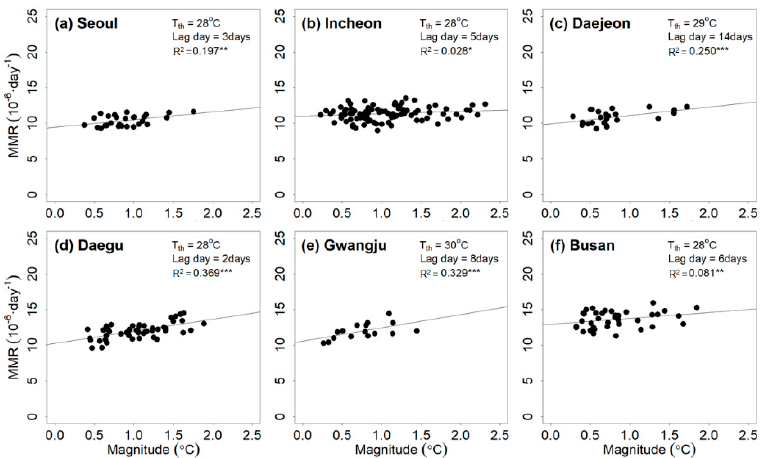
Figure 4. Relationship between the magnitude of the heatwave event based on maximum wet-bulb globe temperature (WBGTmax) and mean total mortality rate (MMR) for ( a ) Seoul, ( b ) Incheon, ( c ) Daejeon, ( d ) Daegu, ( e ) Gwangju, and ( f ) Busan during the training period (2000–2016). Note that ***, **, and * indicate that the R 2 estimates are significant at the 95%, 90%, and 85% levels, respectively; NS indicates that the R 2 estimate is insignificant based on the 85% significance level.